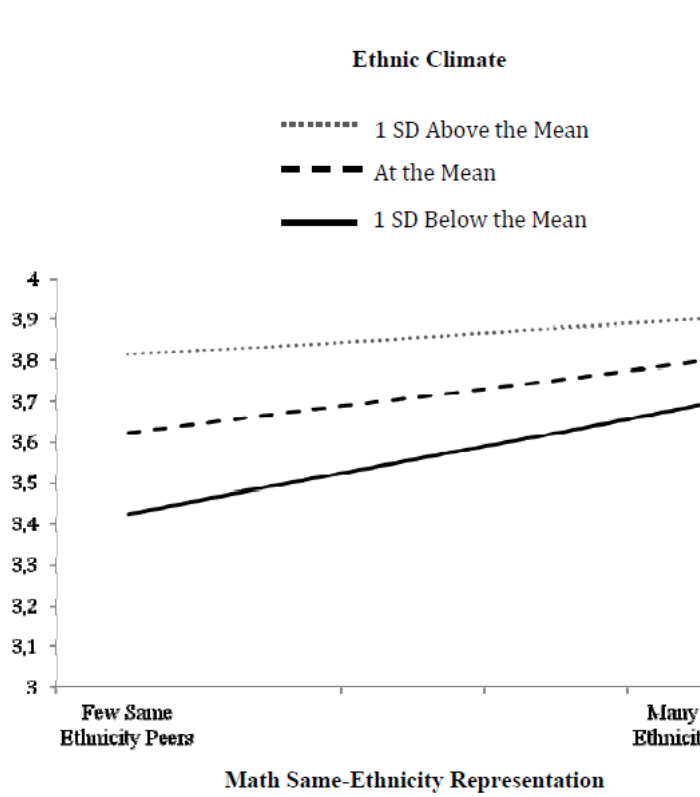
Figure 2. Two-way interaction between ethnic climate and same-ethnicity representation for math